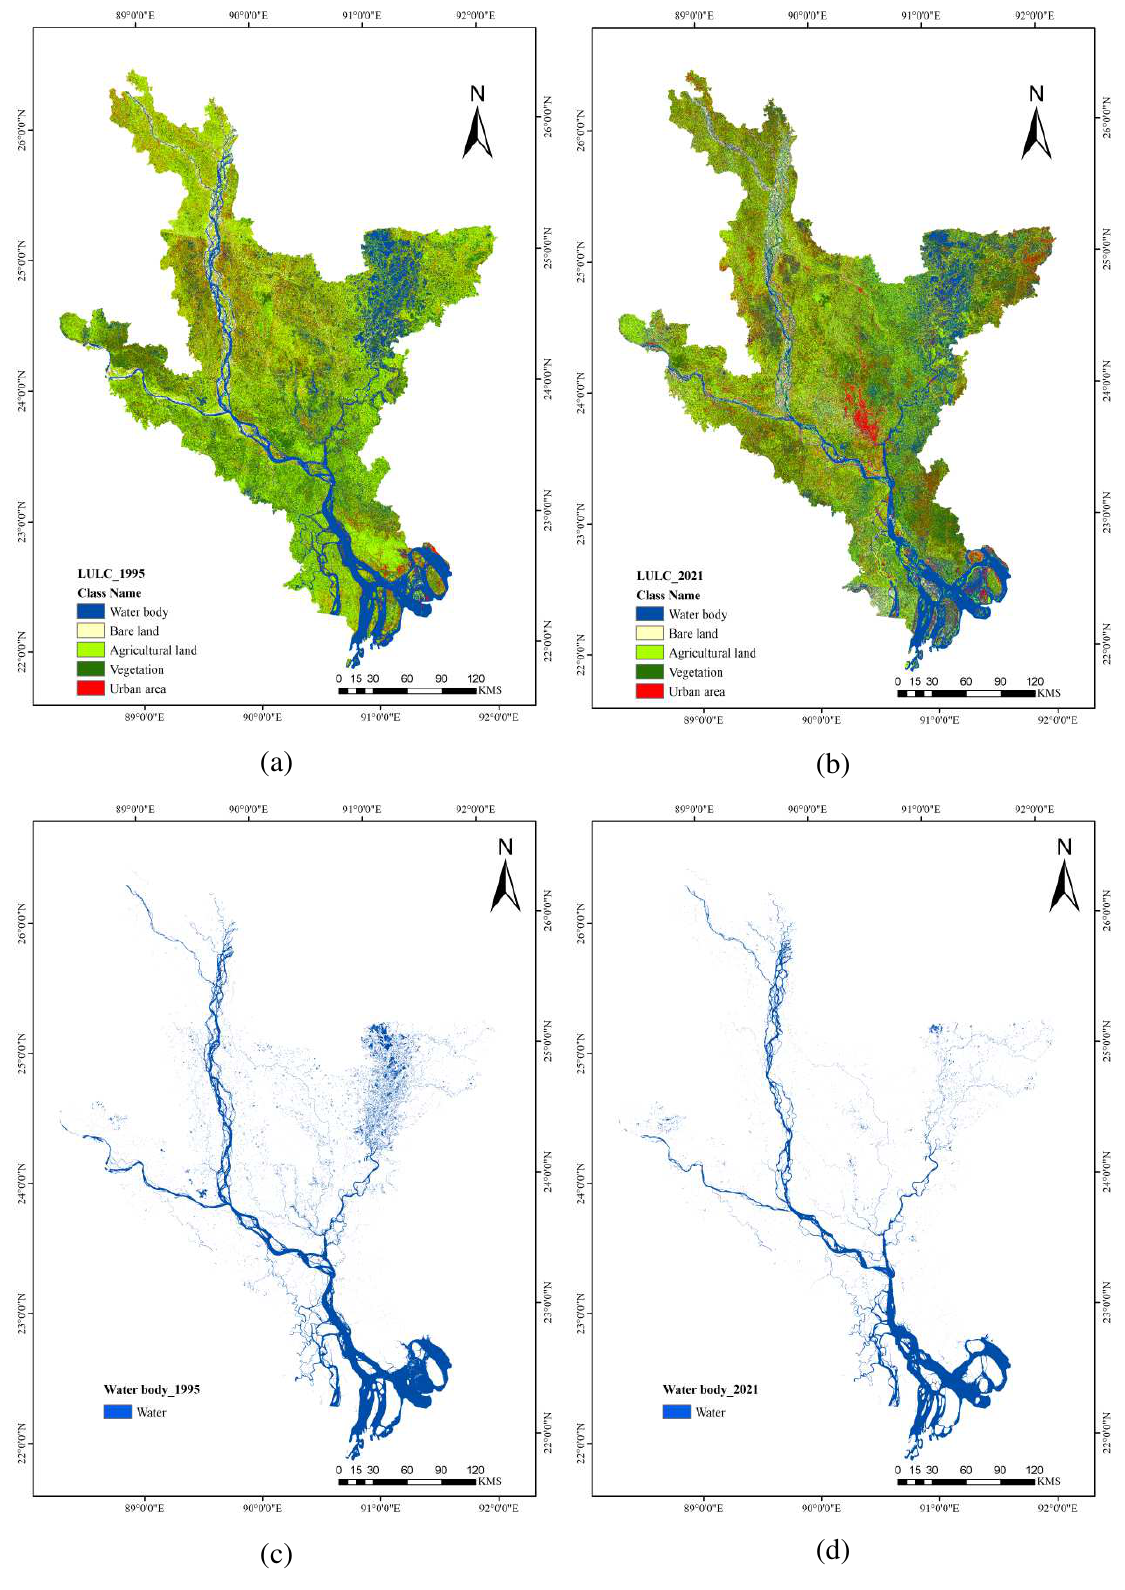
Figure 3. LULC and river distribution as permanent water bodies ( a ) LULC map of 1995; ( b ) LULC map of 2021; ( c ) Permanent water bodies in 1995 and ( d ) Permanent water bodies in 2021.